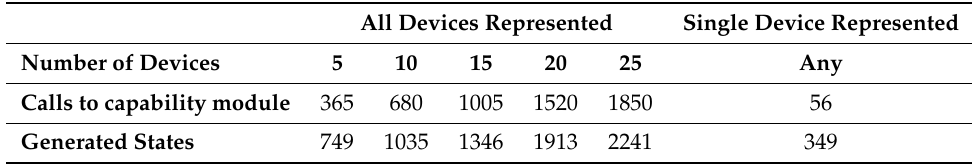
Table 2. Comparison of adding all devices to the PDDL problem versus using a single object to represent all remote devices. “Generated States” is the aggregated number of states TFD/M generated during its search for the